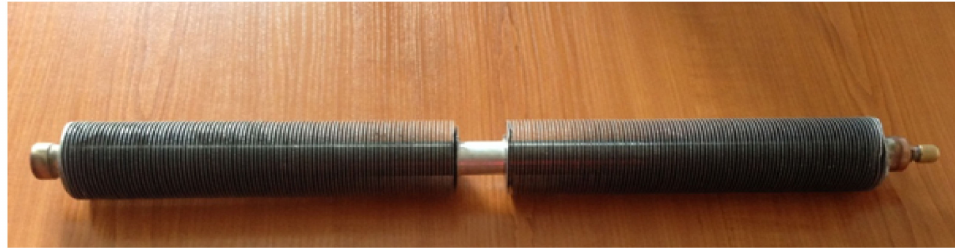
Figure 21. Photo of the finned heat